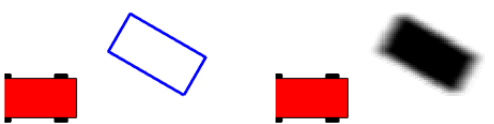
Figure 3. Membership probability map calculated for a CPM object. The ego-vehicle is drawn in red, the CPM object’s box in blue and the membership probability in